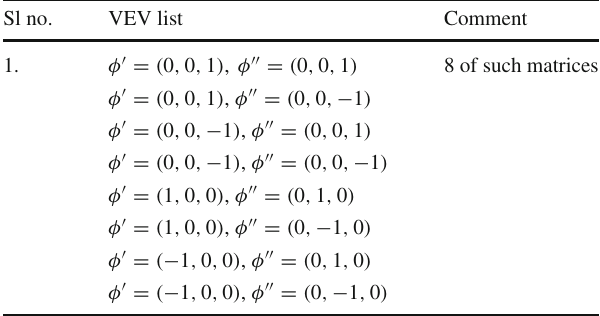
Table 22 VEV alignment of triplet flavon fields φ (cid:3) , φ (cid:3)(cid:3) for texture 3 zero symmetric case, that give rise to same complex constraints Sl